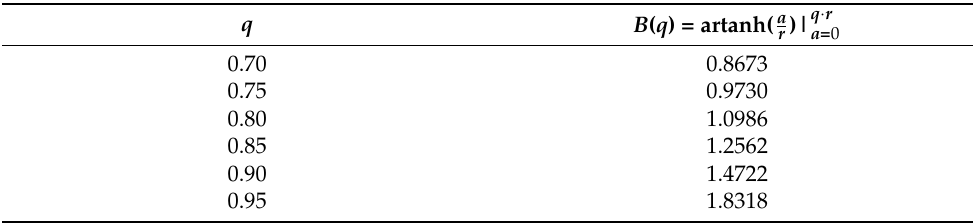
Table 1. Solution of the integral in Equation (7) for different values of q .